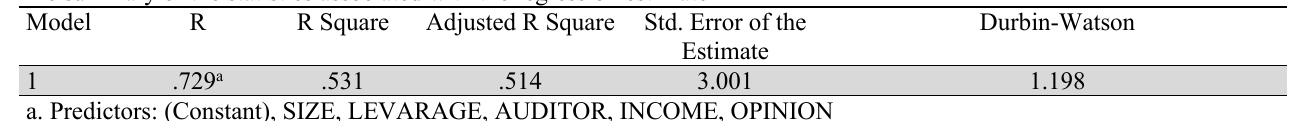
Table 4, 5, 6 present the multiple regression results for the sample. The summary of the statistics associated with the regression